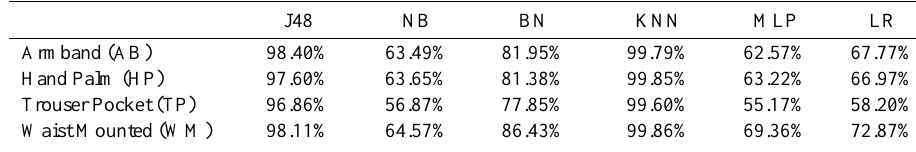
Table 4. Percentage of accuracy – position vs. position (standard deviation